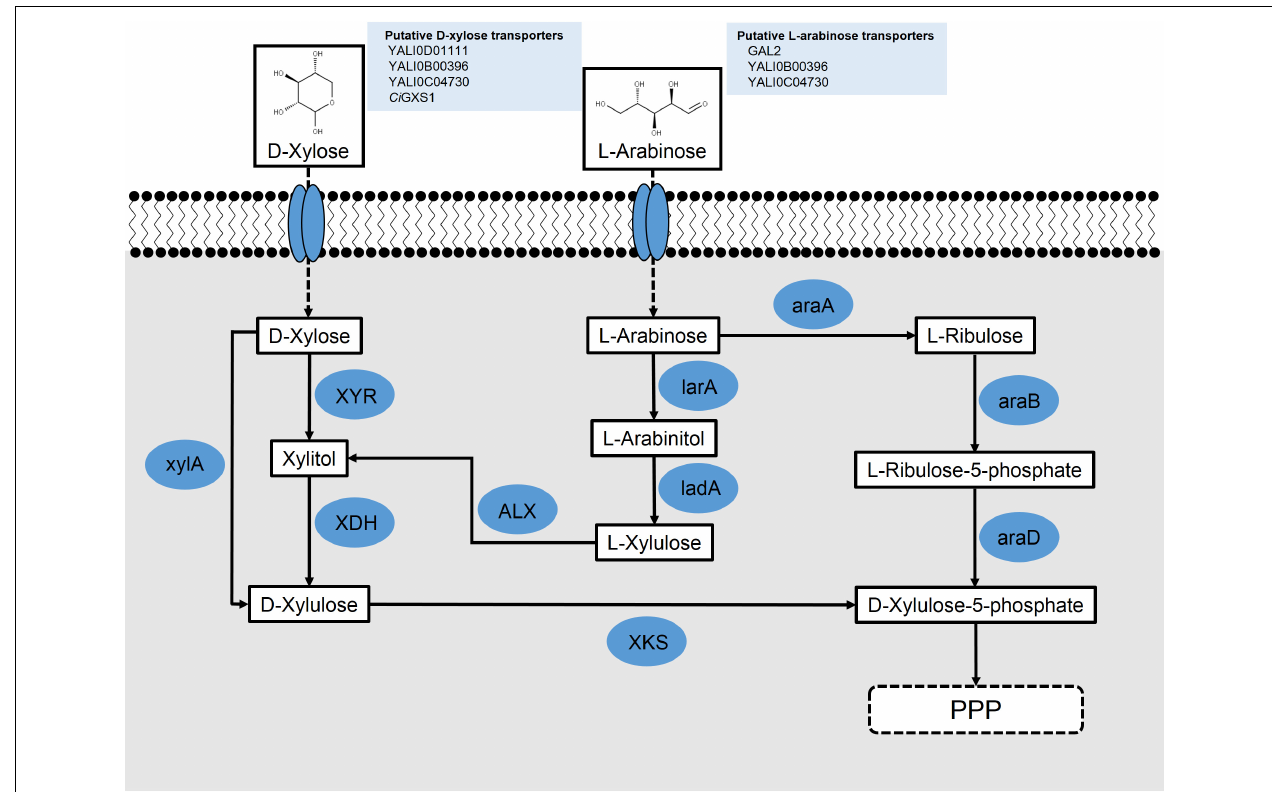
FIGURE 2 | Schematic for the putative metabolism of pentose sugars L -arabinose and D -xylose in engineered Y. lipolytica ; L -arabinose reductase (larA) ( Aspergillus niger ); L -arabinose 4-dehydrogenase (ladA) ( A. niger ); L -arabinose isomerase (araA) ( Bacillus subtilis ); L -ribulokinase (araB) ( Escherichia coli ); L -ribulose-5-phosphate 4-epimerase (araD) ( E. coli ); L -xylulose reductase (ALX) ( Ambrosiozyma monospora ); xylose reductase (XYR); xylose dehydrogenase (XDH); xylulokinase (XKS); and xylose isomerase